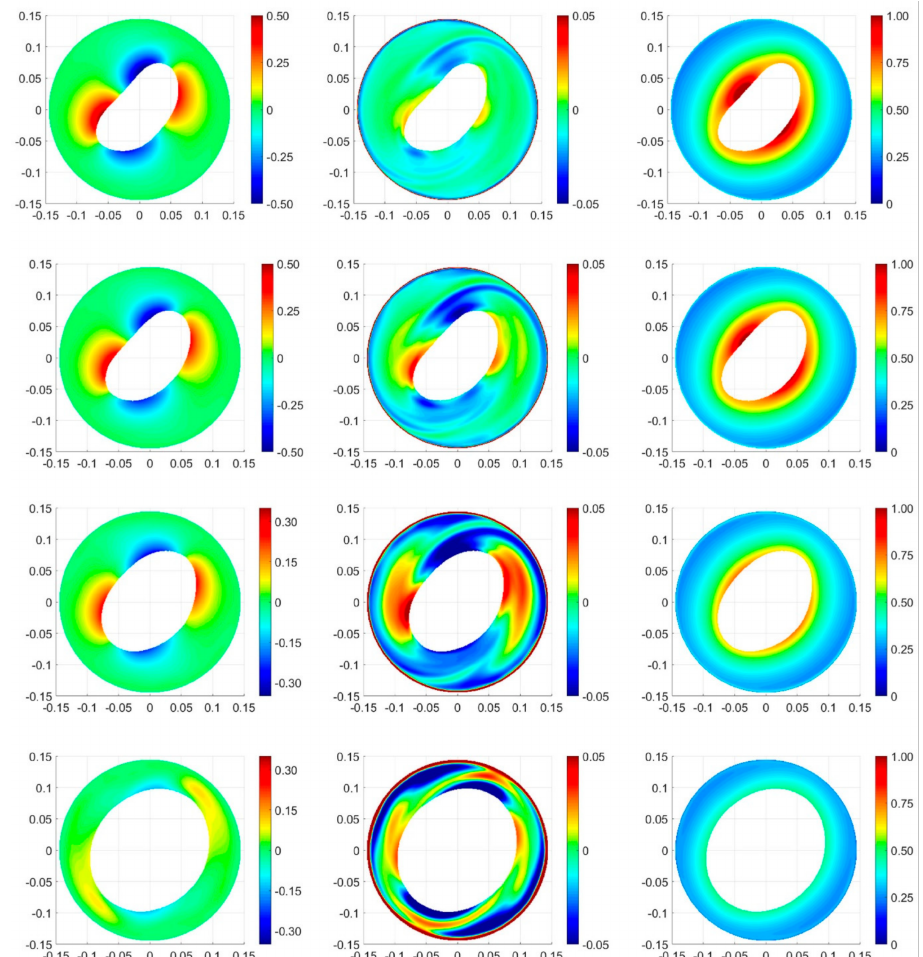
Figure 8. Top view of the radial, axial (both in m/s) and normalized tangential average velocities at four heights (from top to bottom: 5, 10, 30 and 60 mm) above the 3.4 Hz rotating disk. Each contour is rotated to the contour of t = 0 s using maximum correlation between the shapes. Velocity values are averaged if the specific location was occupied by water more than 50% of the frames, otherwise white color is